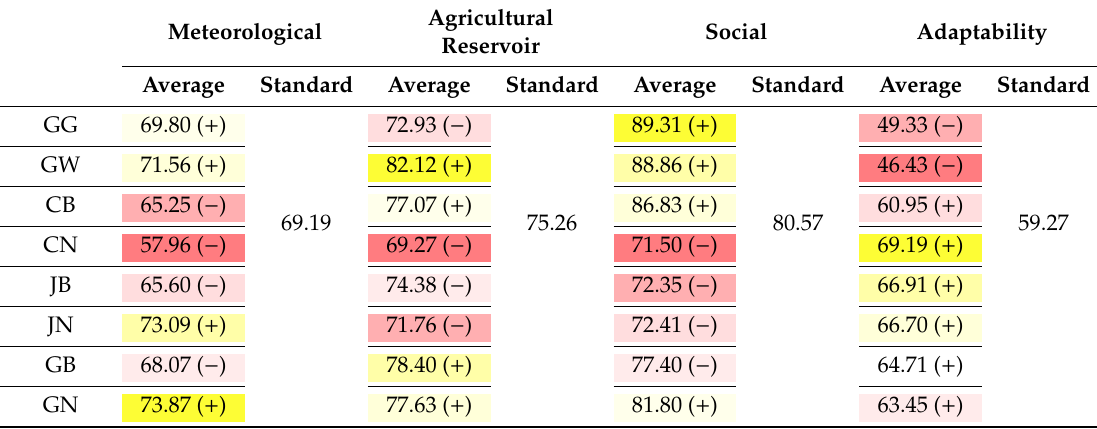
Table 6. Comparison of the average score for each factor related to vulnerability to agricultural drought and the national average score. Red represent lower than the standard value. Yellow represent higher than the standard